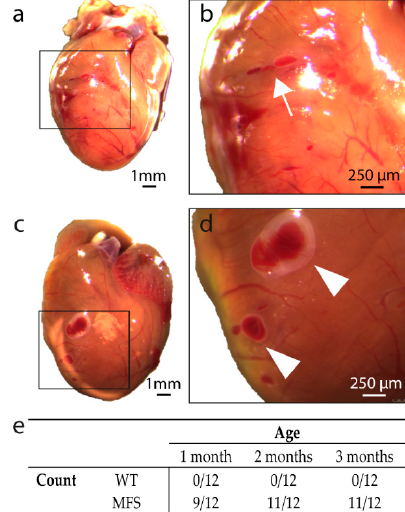
Figure 1. Macroscopic characterization of the heart of WT and MFS mice at 1, 2, and 3 months of age. Dot plot visualizes individual heart weight / tibia length ratios and mean value per age and genotype ( n = 12 per age and genotype). WT and MFS measurements are indicated in grey and black, respectively. Error bars represent standard error. Associated p -values are annotated at the top of the graph (independent samples test on the mean values of the HW / TL). At the bottom of the figure, representative macroscopic pictures of WT and MFS mice hearts collected at 1, 2, and 3 months of age are depicted. Scale bar: 2 mm. HW / TL, heart weight to tibia length ratio (g / mm); WT, wild-type; MFS, Marfan syndrome.